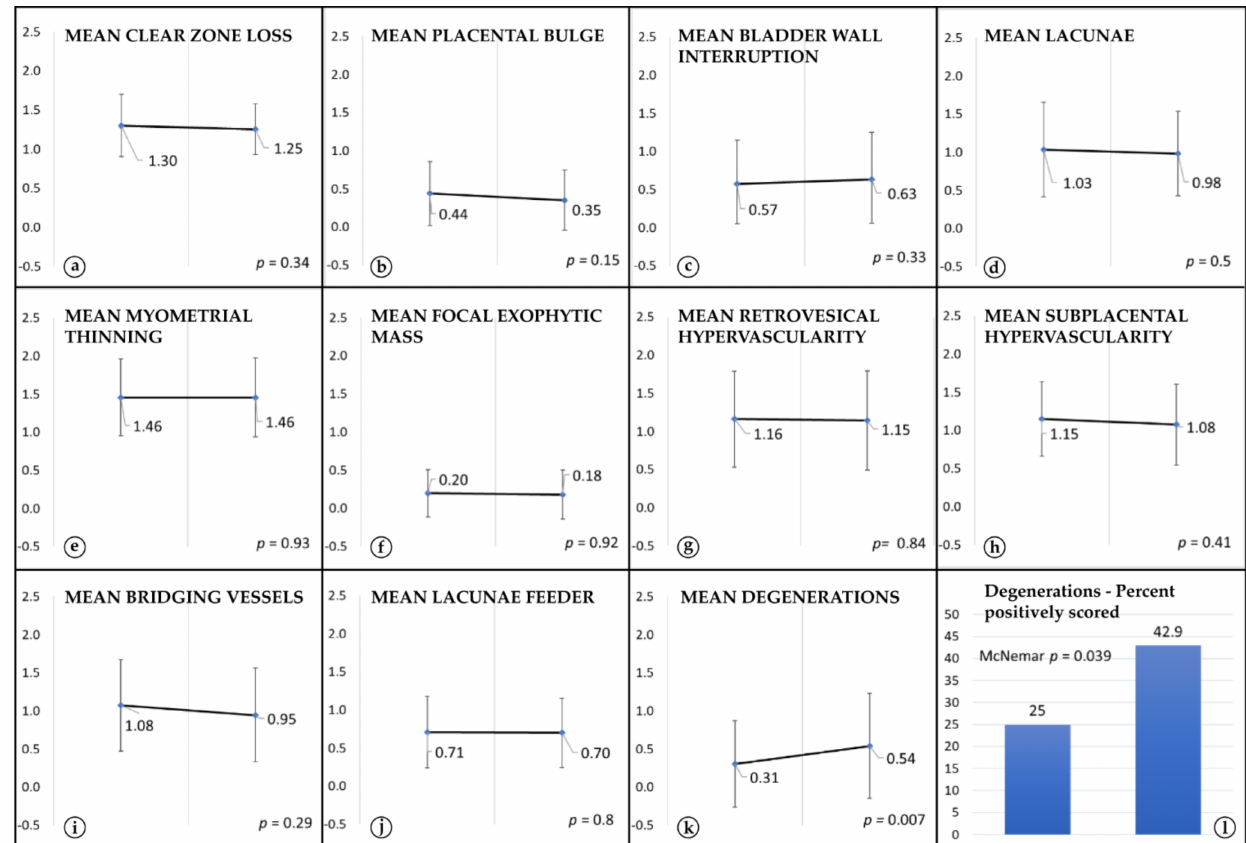
Figure 1. Comparison of severity estimates: There was no visible change in severity appearance of the 10 AIP ultrasound signs ( a , c – j ) except for a decrease in severity of the placental bulge ( b ) and an increase for the comparator sign, i.e., placental degenerations ( k ) (y-axis: mean severity of appearance ± std. dev. per visit). Significantly more degenerations could be noted at the later US scan ( l , percent of positively